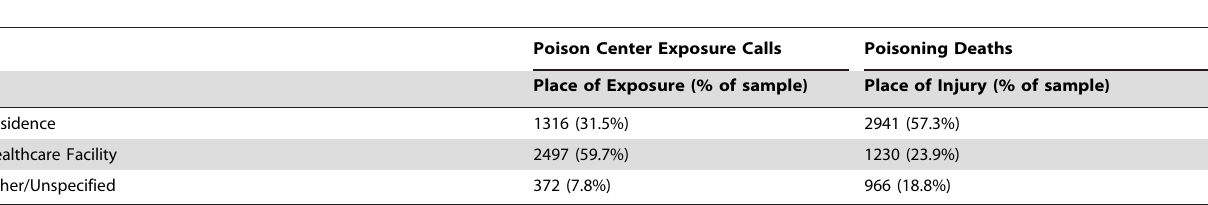
Table 2. Places of exposure/injury from methadone among poison center exposure calls and poisoning deaths, 29 states, United States, 2006–2007.